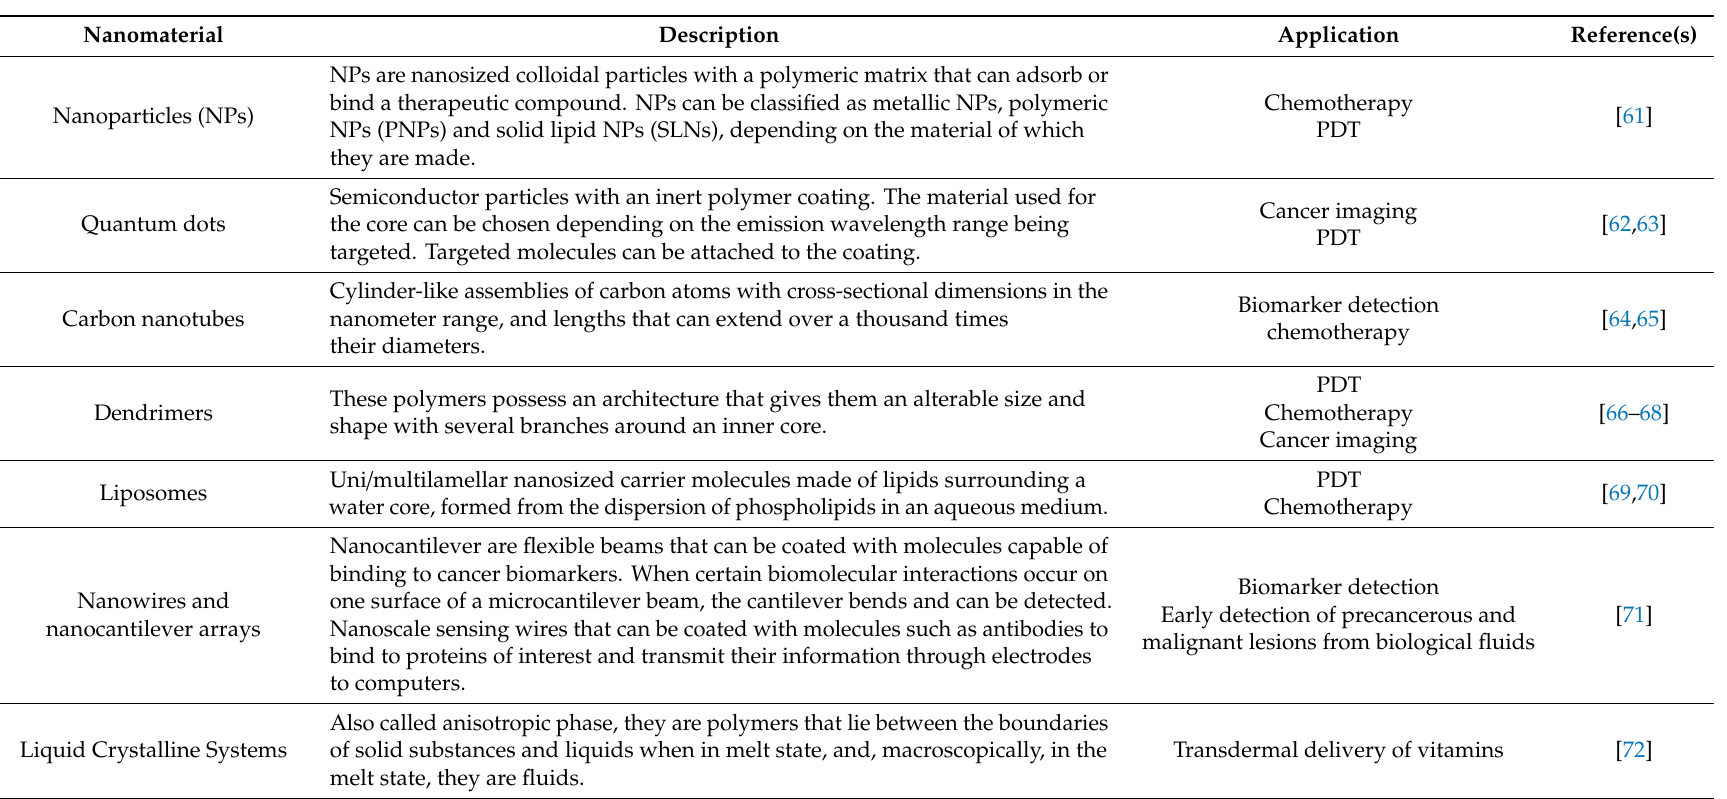
Table 2. Nanomaterials used in